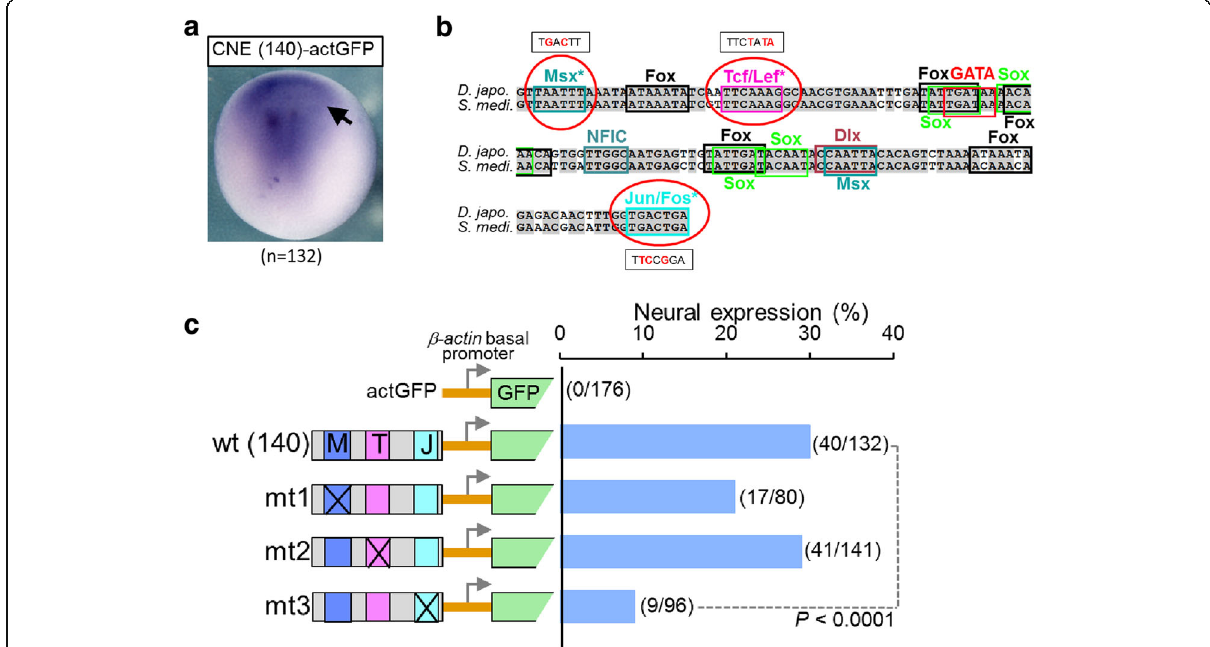
Fig. 7 Transgenic experiments suggested that Djndk CNE3 might be a regulatory element. a The arrowhead shows CNE3 inserted actGFP vector, CNE (140)-actGFP driven GFP to express in the anterior region at the end of gastrulation in transgenic Xenopus embryos ( n = 132). b Putative transcription factor-binding motifs are boxed in different colors; those subjected to mutation analysis are indicated by asterisks. The detailed point mutation design of three transcription factor-binding motifs are shown by red colored words. c Mutation analysis of CNE3 (the 140 bp element). actGFP is an empty reporter construct that contains the β -actin basal promoter; wt (140) is the construct of CNE (140)-actGFP used in ( a ); mt1, m2 and mt3 are point mutations (Msx (M), Tcf/Lef (T), and Jun/Fos (J)) generated from wt (140), and the detailed mutation design is shown in ( b ). The bar chart shows the percentage of the embryos that showed GFP expression in the neural plate among total developed embryos injected with the vector constructs. Actual numbers of GFP-positive cases and total numbers of scored embryos are indicated in parentheses. The chi- square test showed that the percentage of positive cases in the wt (140) and the Jun/Fos mutant constructs are significantly different ( P < 0.0001), whereas the differences observed in other cases were not significant ( P >